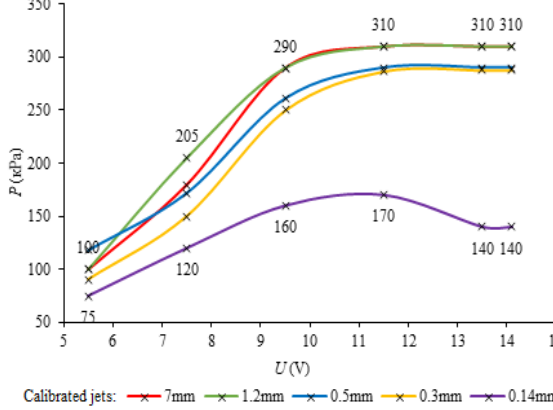
Figure 7. The dependence of the pressure change in the supply system on the voltage of the EFP when using calibrated jets of various flow passage diameters (0.14 mm...7 mm)